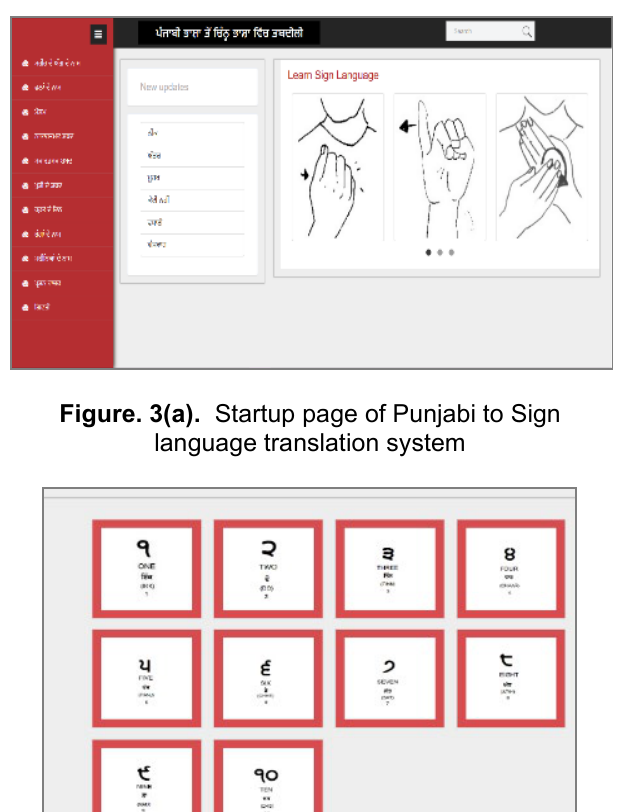
Figure 3(d). 3D avatar representing gesture of word “One ( ਇੱਕ